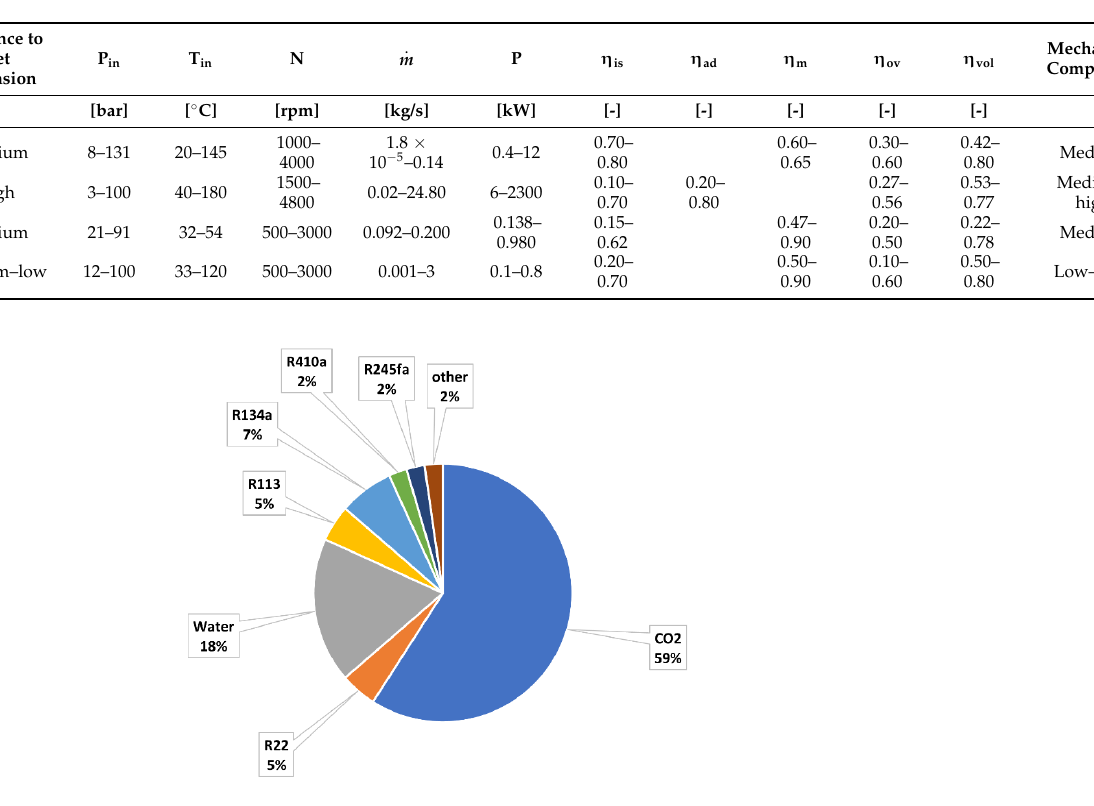
Figure 20. Percentage distribution of the fluids employed in the selected studies.